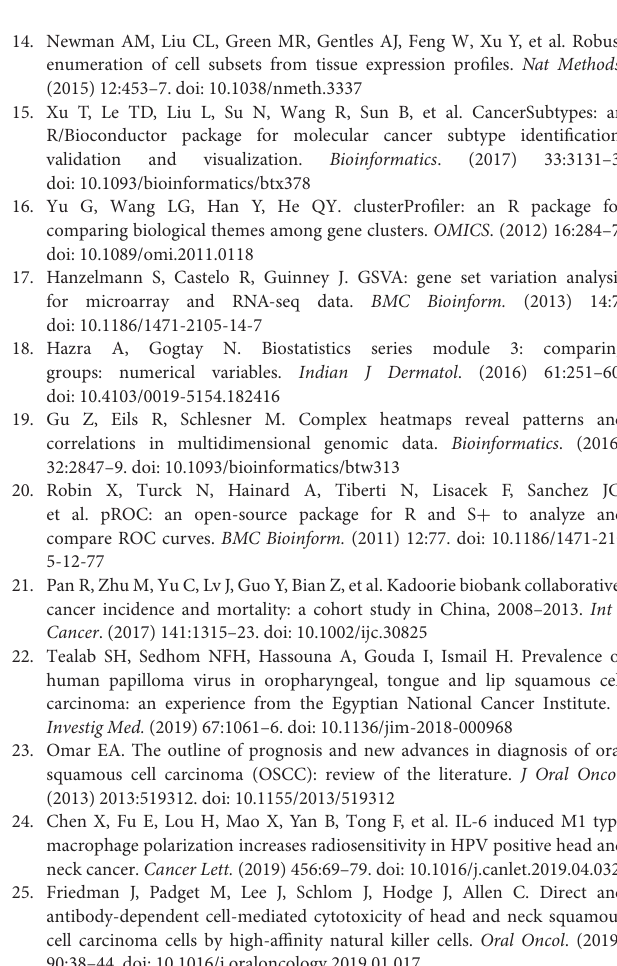
Supplementary Table 1 | Comparison of CIBERSORT immune fractions between grade G1/G2 and G3/G4. Supplementary Table 2 | Comparison of CIBERSORT immune fractions between with and without radiation